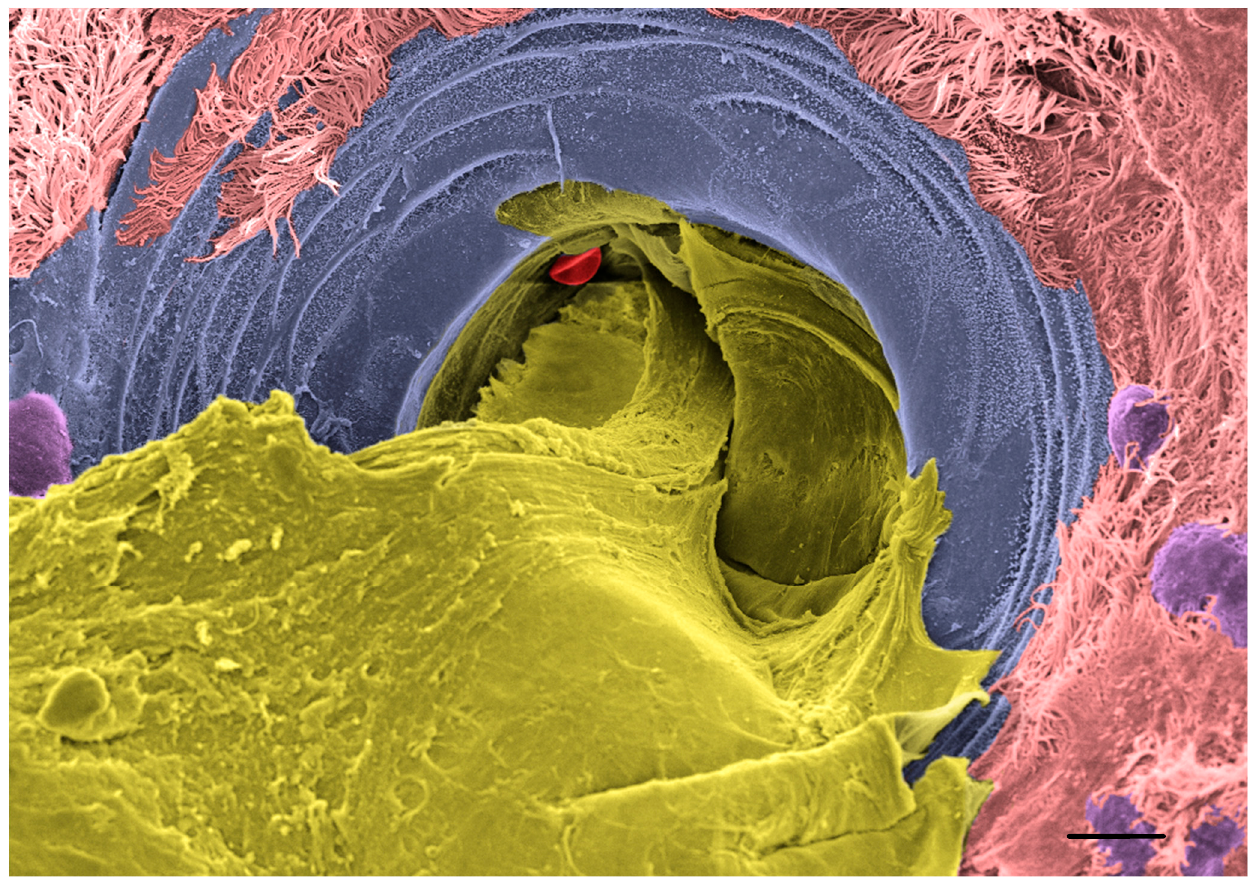
Figure 2. Scanning electron microscope (SEM) image of a CF submucosal gland duct obstructed by mucus. Large airways were collected from a CF lung at the time of transplant, stimulated with methacholine (10 μ M) for 30 min and processed for SEM. Image was acquired with a Zeiss Supra 25 SEM and colorized using Adobe Photoshop software. Color schemes show mucus in yellow, cilia in pink, gland duct in blue, secretory cells in purple, and a red blood cell in red. Scale bar 10 μ m.